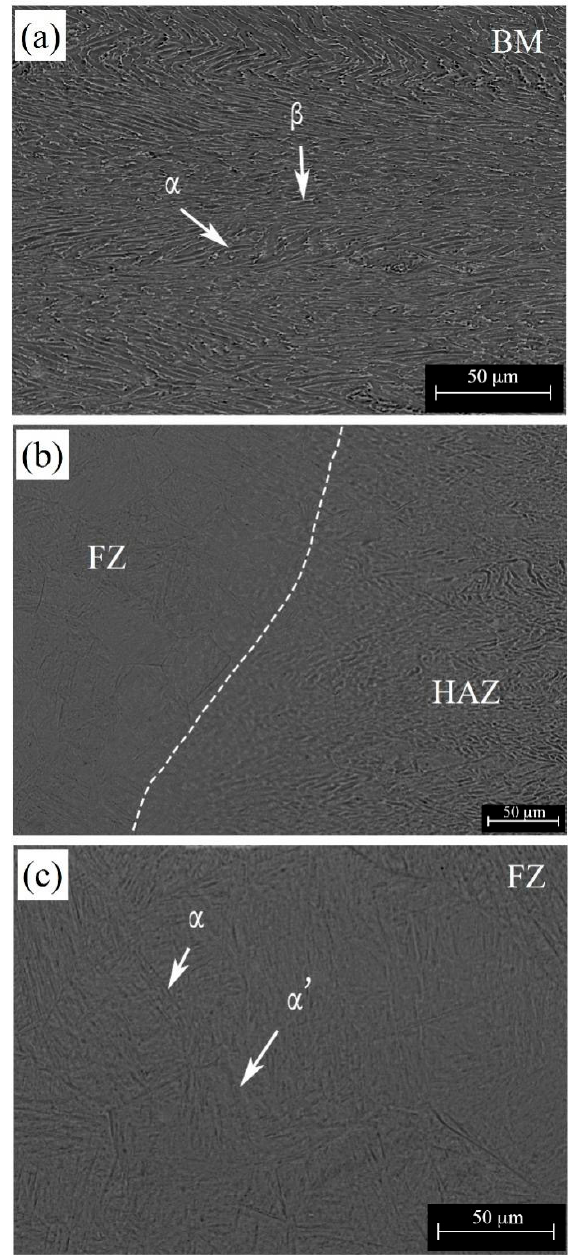
Figure 7. Backscattered electron images of the cross-section of W2 joint: ( a ) Base material (BM); ( b ) Heat-affect zone/Fusion zone (HAZ/FZ) transition zone; ( c ) Fusion zone (FZ).